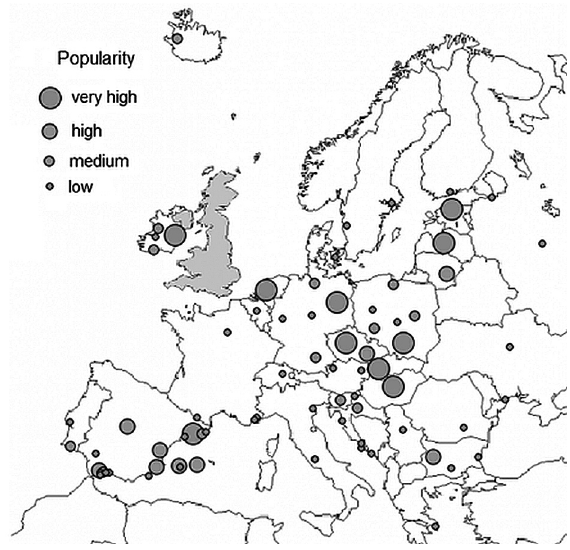
Fig. 5. Popularity of European stag party tourism centres based on the analyzed